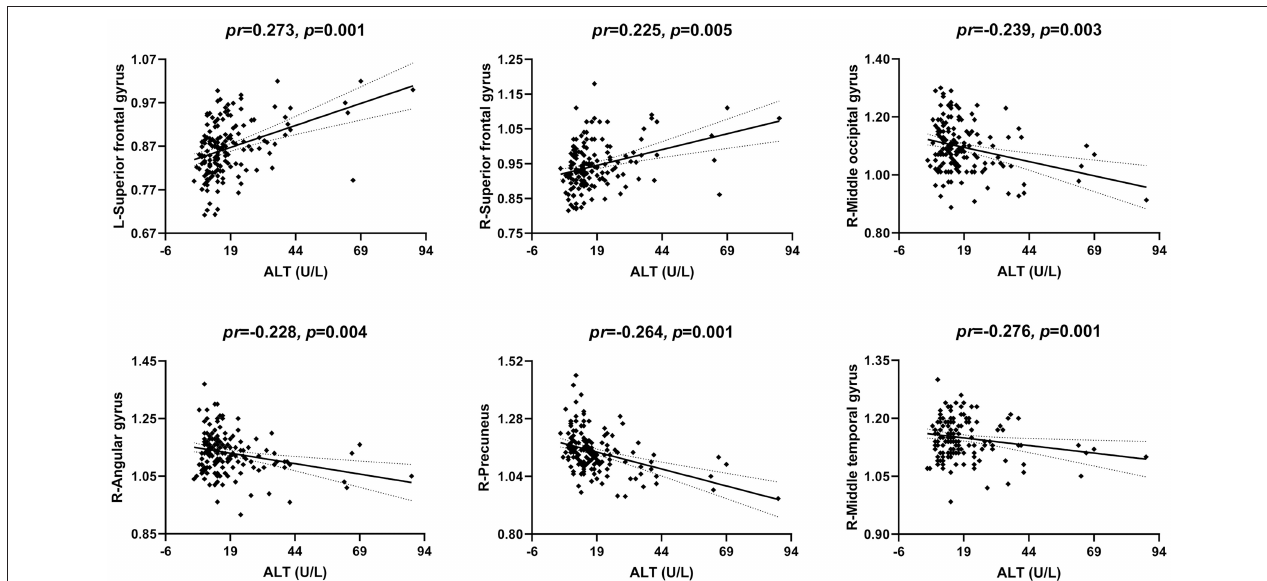
FIGURE 5 | Scatter plots of the correlations between serum ALT and CBF. Abbreviations: ALT, alanine transaminase; CBF, cerebral blood flow; pr , partial correlation coefficient; L, left; R, right.